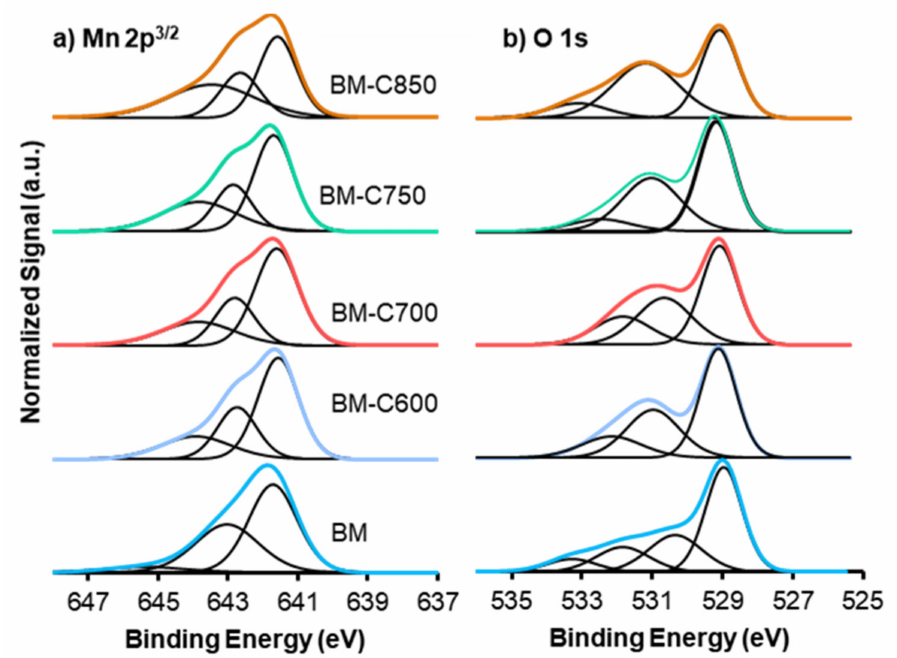
Figure 5. XPS spectra of ( a ) Mn2p3/2, and ( b ) O1s transitions of BM-CX series and BM as